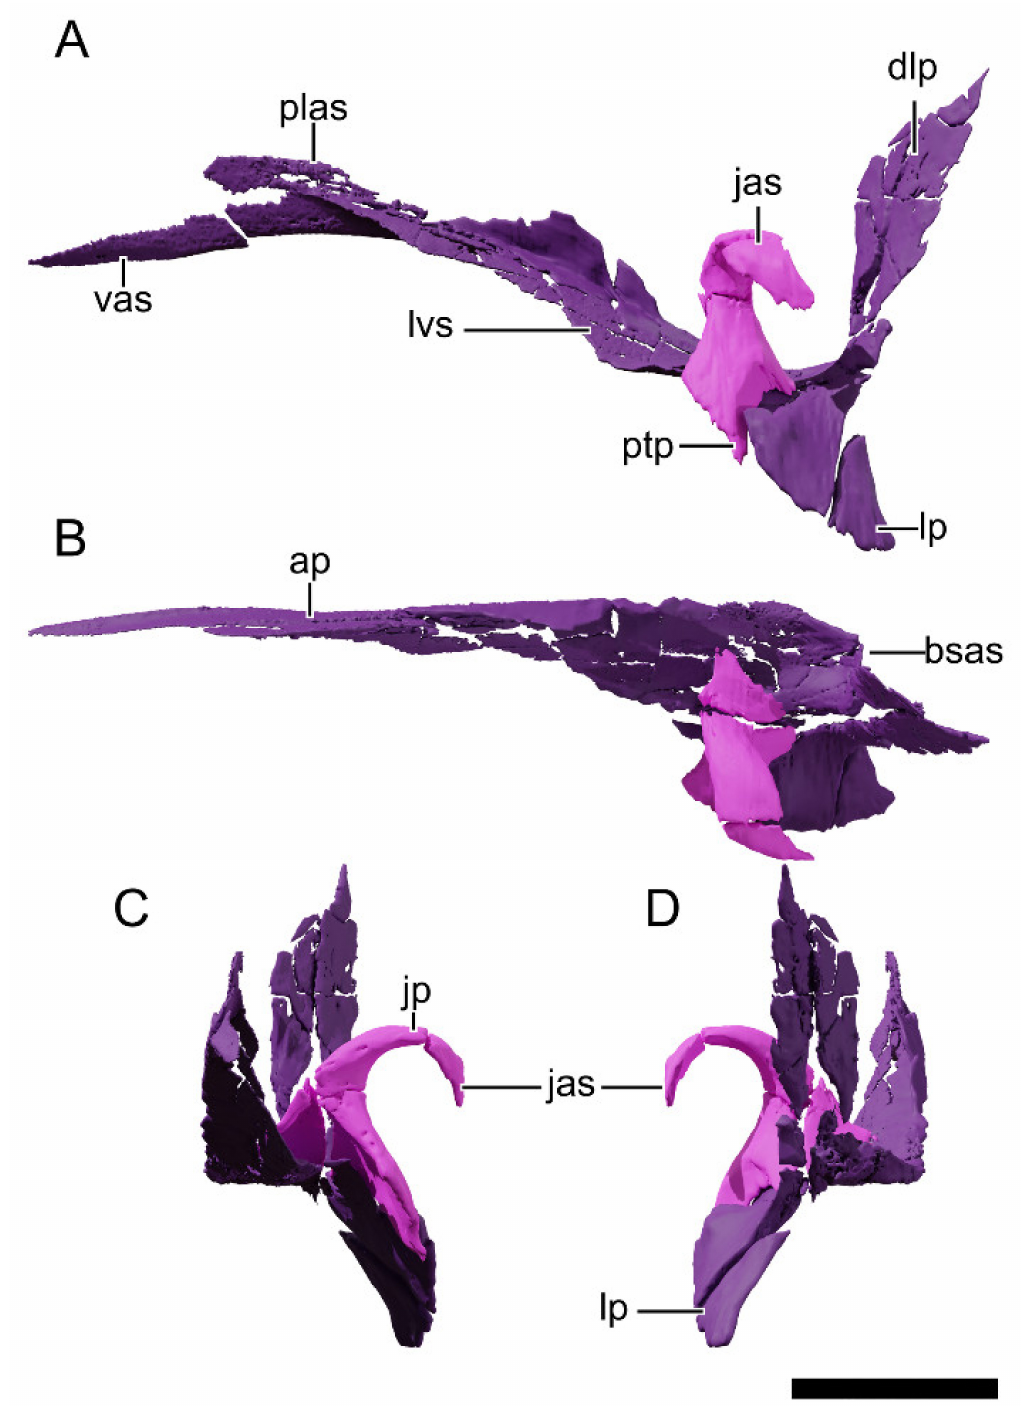
Figure 28. Digital reconstruction of the left pterygoid and ectopterygoid of NHMD 164758. ( A ) Lateral view. ( B ) Dorsal view. ( C ) Anterior view. ( D ) Posterior view. Abbreviations: ap, anterior process; bsas, articular surface for the basisphenoid; dlp, dorsolateral process; ecf, ectopterygoid fossa; jas, articular surface for the jugal; jp, jugal process; lp, lateral process; lvs, lateroventral sheet of bone; mp, medial process; plas, articular surface for the palatine. Scale bar = 20 mm. The lateral process of the pterygoid is anteroposteriorly expanded and dorsoventrally flattened. This process is separated from the anterior process by an almost 90 ◦ angle in lateral view. The medial surface that separates both processes is highly